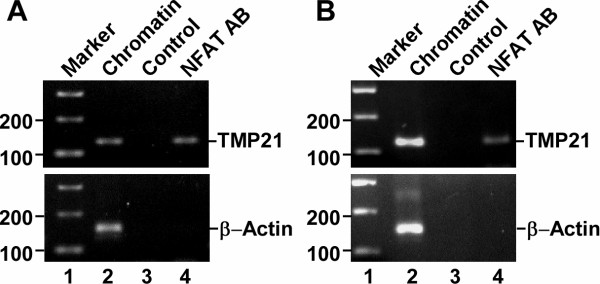
ChIP assay to show that NFAT proteins are associated with human TMP21 promoter. ChIP assay was performed as described in the Material and Methods. The chromatin was isolated HEK293 (A) or SH-SY5Y cells (B), and then sheared from the cells treated with cross-link reagent formaldehyde. For isolation of NFAT binding complex, the chromatin solution was incubated with NFAT antibody (Santa Cruz). PCR amplifications were performed using TMP21 promoter-specific primers, with samples from the sheared chromatin alone (lane 2), non-NFAT antibody control (lane 3) and NFAT-immunoprecipitating chromatin sample (lane 4). β-actin was used as internal control.